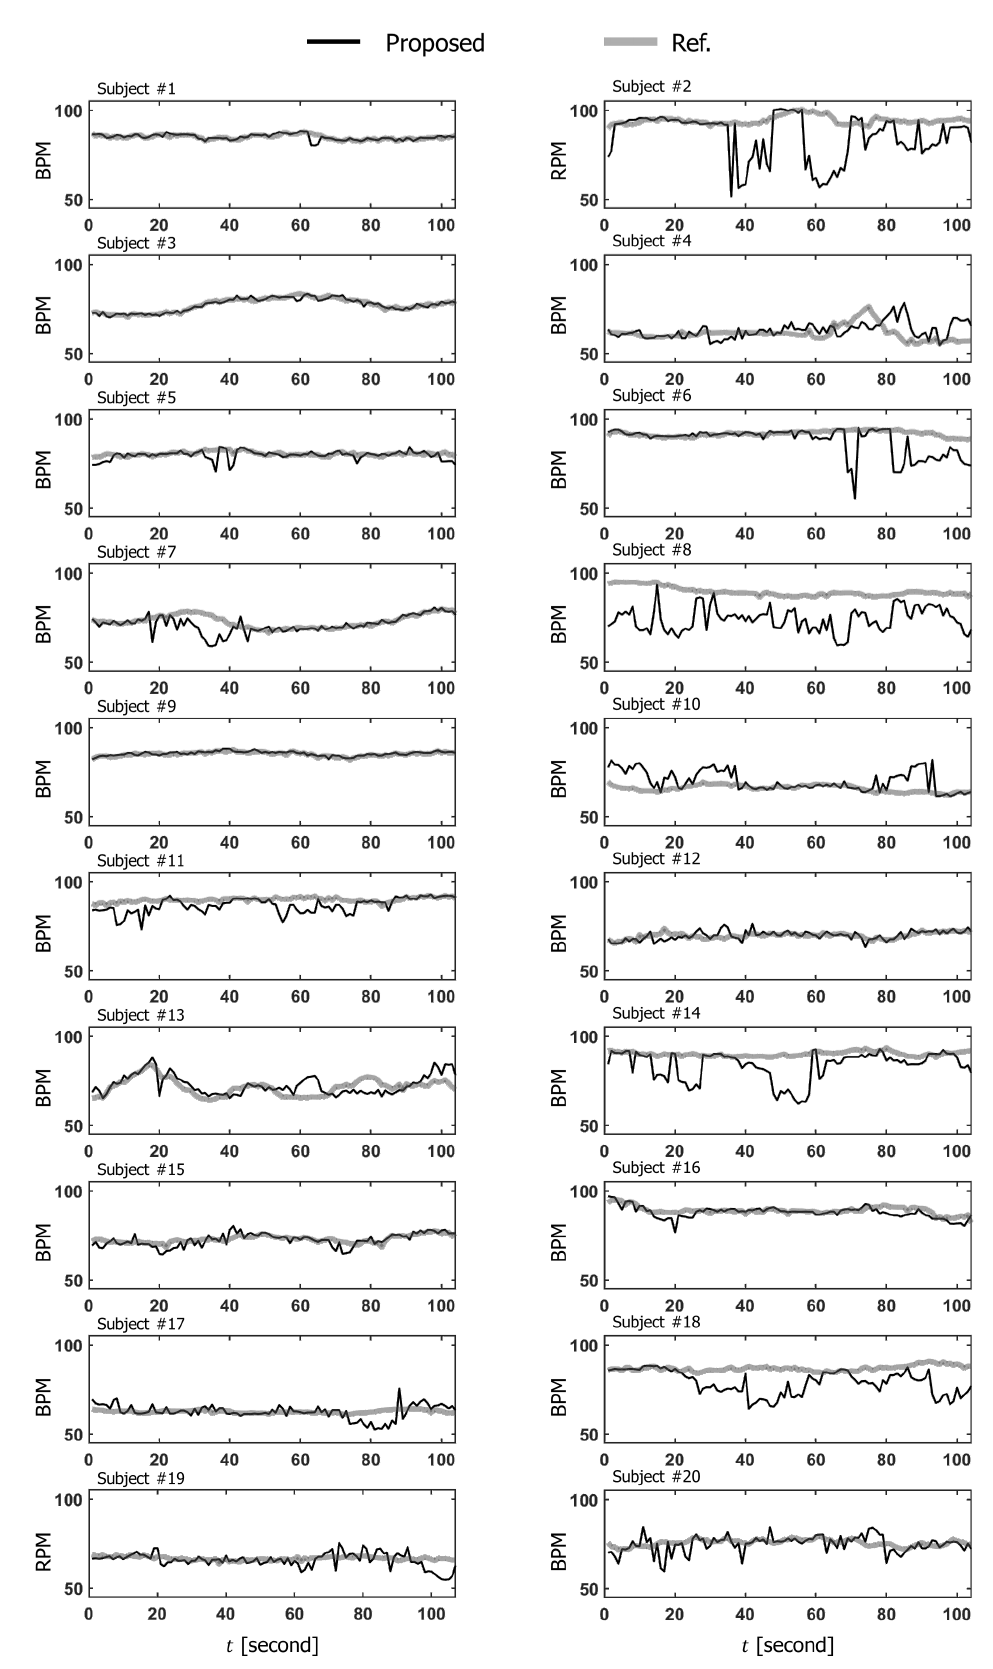
Figure 7. Comparison of the extracted heart rate using the proposed method with the referenced ground truth for 20